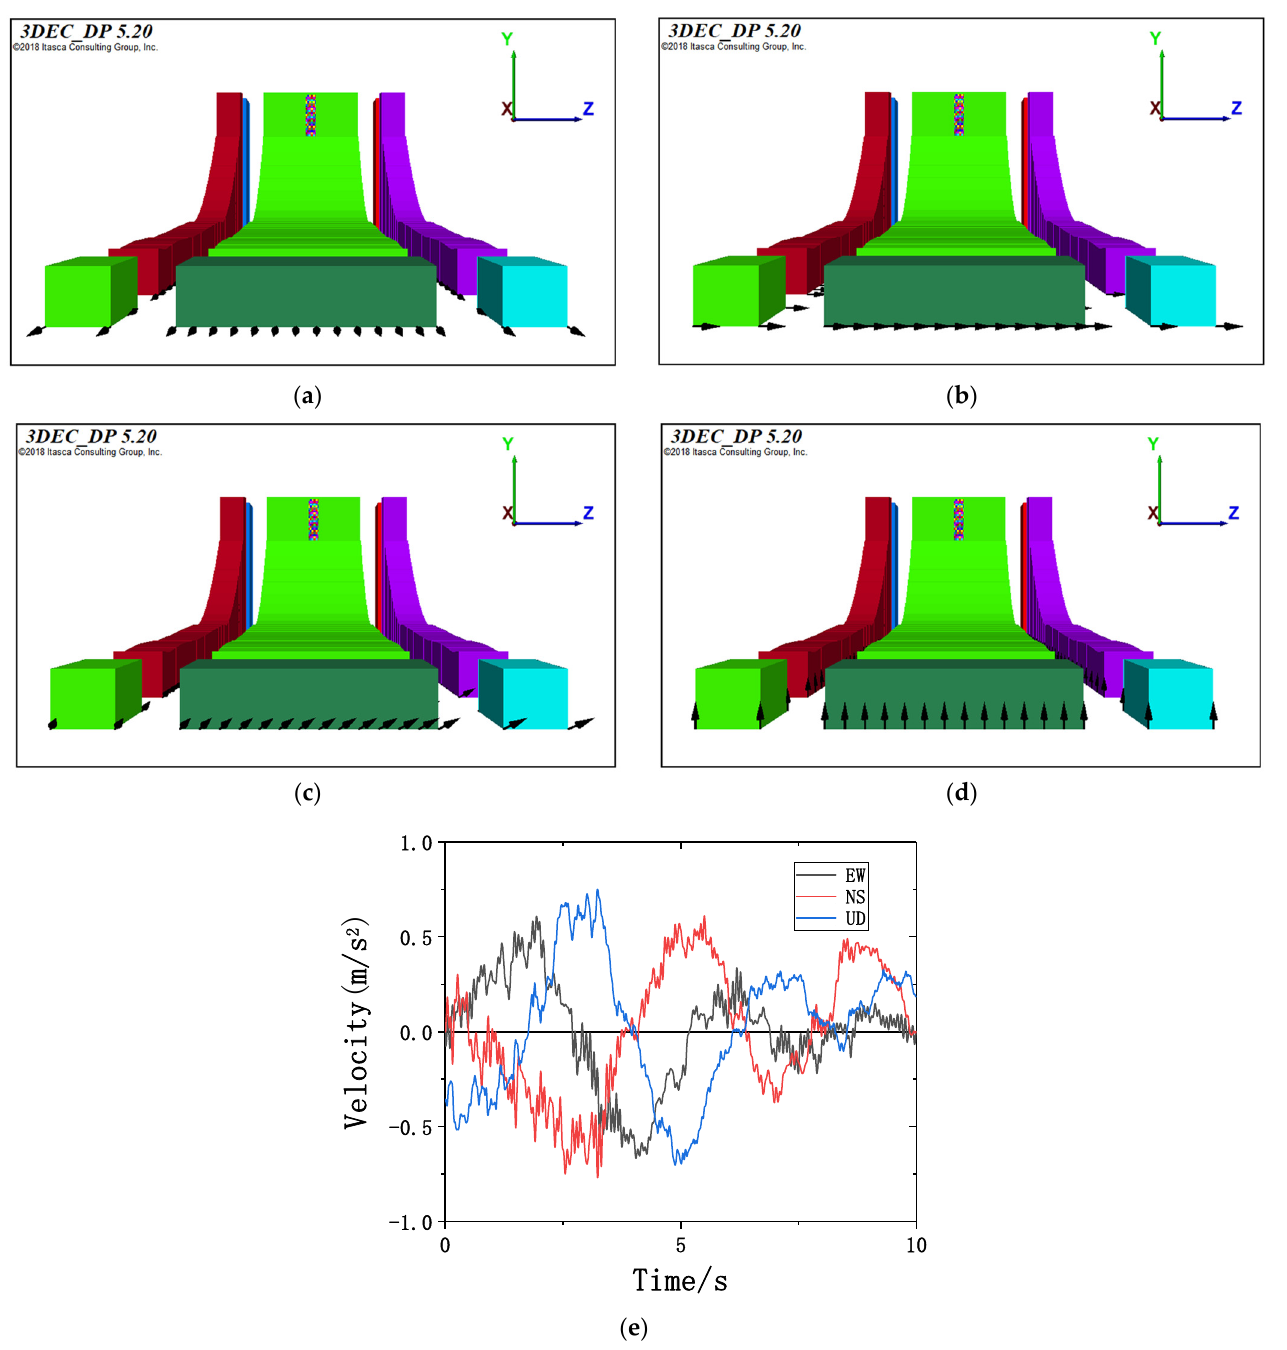
Figure 10. The input of seismic waves in 3DEC. ( a ) Case 1: EW seismic wave; ( b ) case 2: NS seismic wave; ( c ) case 3: UD seismic wave; ( d ) case 4: EW_NS_UD seismic wave. ( e ) The input seismic wave curves.